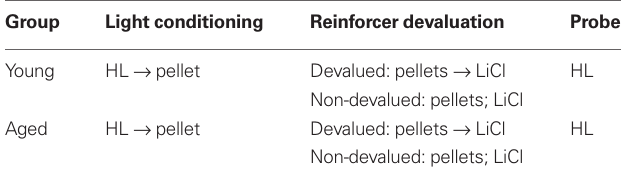
Table 1 | Outline of experimental